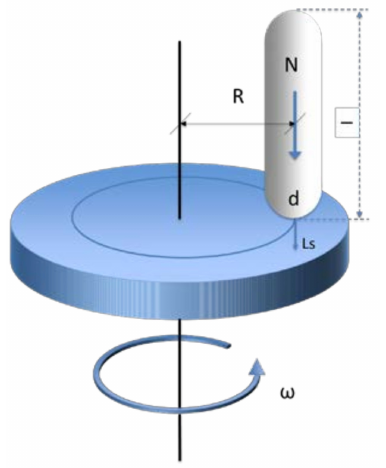
Figure 2. Pin-on-Disc tribometer motion diagram.